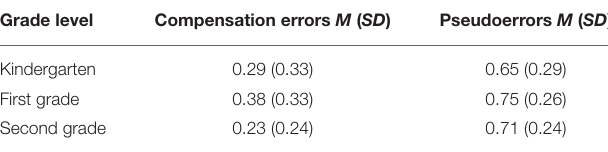
TABLE 7 | Means and SD of absolute accuracy